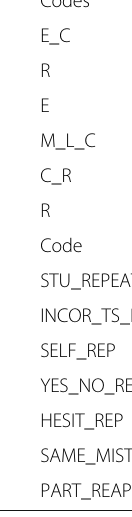
Table 4 Codes for correction strategies and repair moves based Lyster and Ranta (1997) Correction